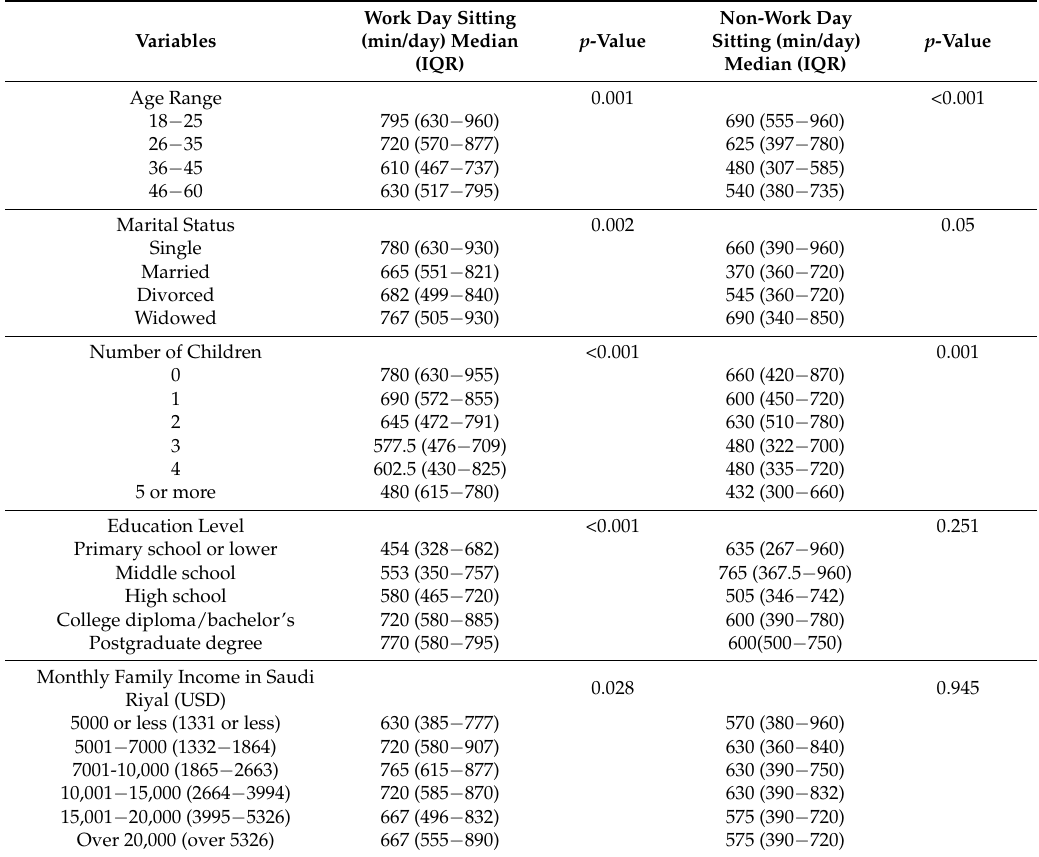
Table 4. Median sitting time on work days and non-work days (min/day) for selected demographics, BMI, and physical activity levels of Saudi female